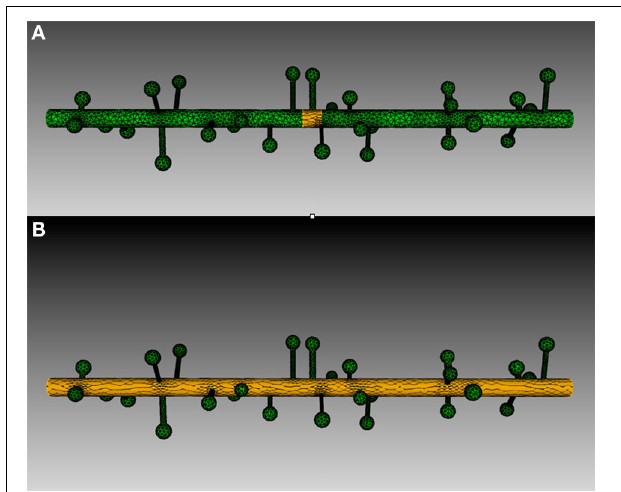
FIGURE 9 | Tetrahedron selection using geometry preparation toolkit of (A) Injection zone and (B) dendritic shaft. A cylinder-bounding object is firstly created, as highlighted in the figure. Tetrahedrons in the mesh that are within the bounding object are selected by the toolkit and stored in the ROI dataset.